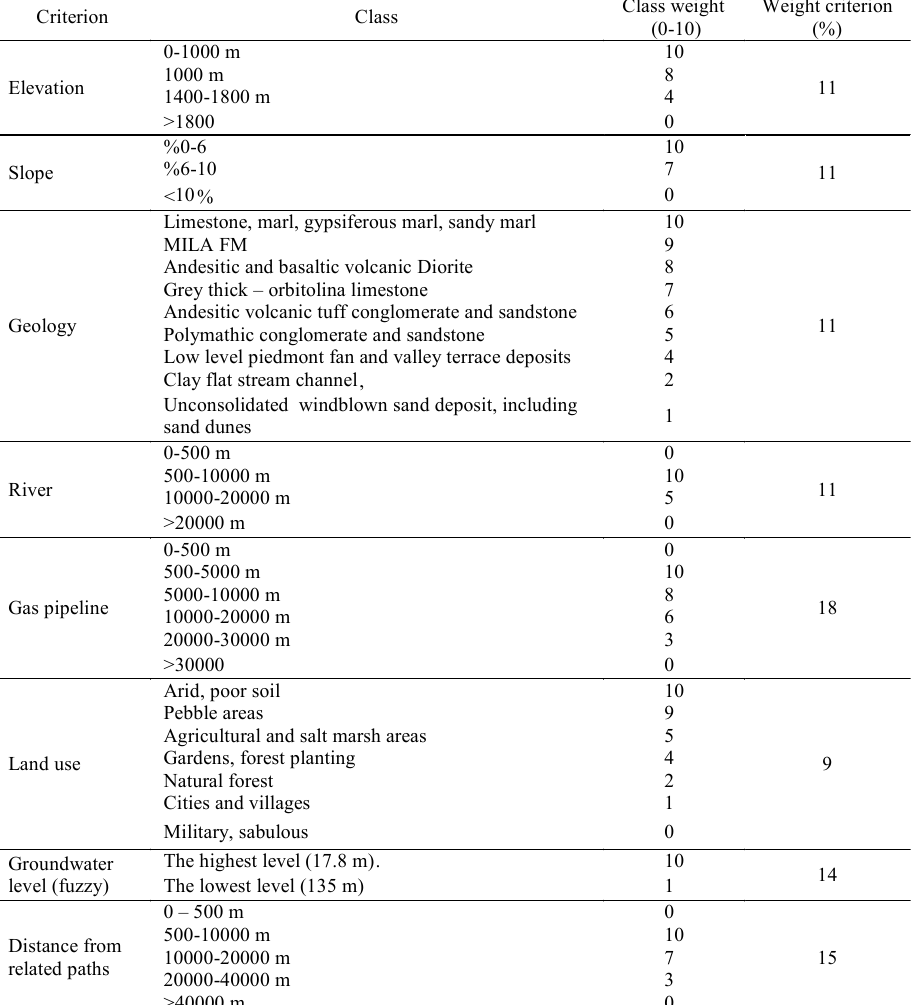
Table 2: Weights and classes of